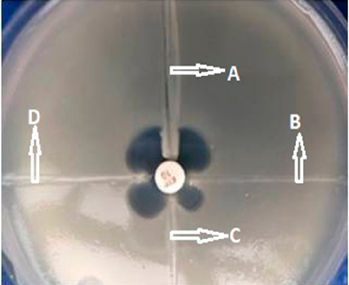
Fig. 1. Modified Hodge Test (A is Negative control, B is Positive control, C and D are two test isolates showing positive